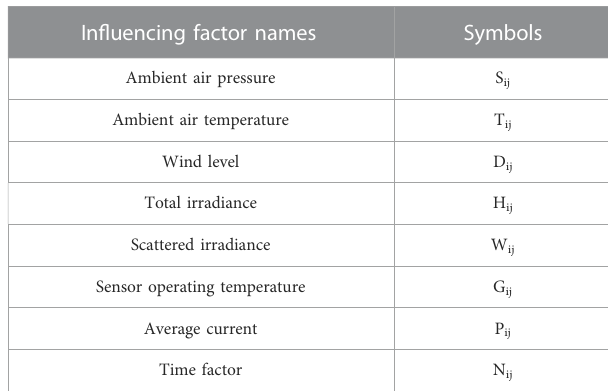
TABLE 2 In fl uencing factor symbols and corresponding